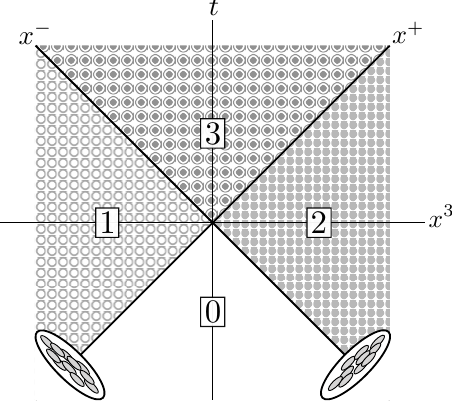
Figure 1 . Space-time diagram of the collision of two ultra-relativistic heavy ion nuclei. The two diagonal lines represent the trajectory of the nuclei. The points below them (quadrant 0) represent a region where the projectiles have not yet arrived. By choosing the gauge (cid:12)elds to vanish in the remote past, in this region we have A (cid:22) = 0. As quadrants 1 and 2 represent regions where only one of the nuclei has arrived, the dynamics of the gauge (cid:12)elds there are described by the Yang-Mills equations with a single source. However, in quadrant 3 we need to take into account both